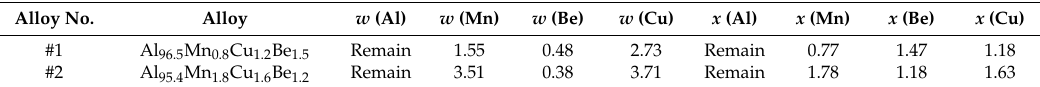
Table1. Chemicalcompositionsoftheinvestigatedalloysaftervacuuminductionmelting, asdetermined by Atomic Emission Spectroscopy–Inductively Coupled Plasma ( w —weight fraction in %, x —atomic fraction in